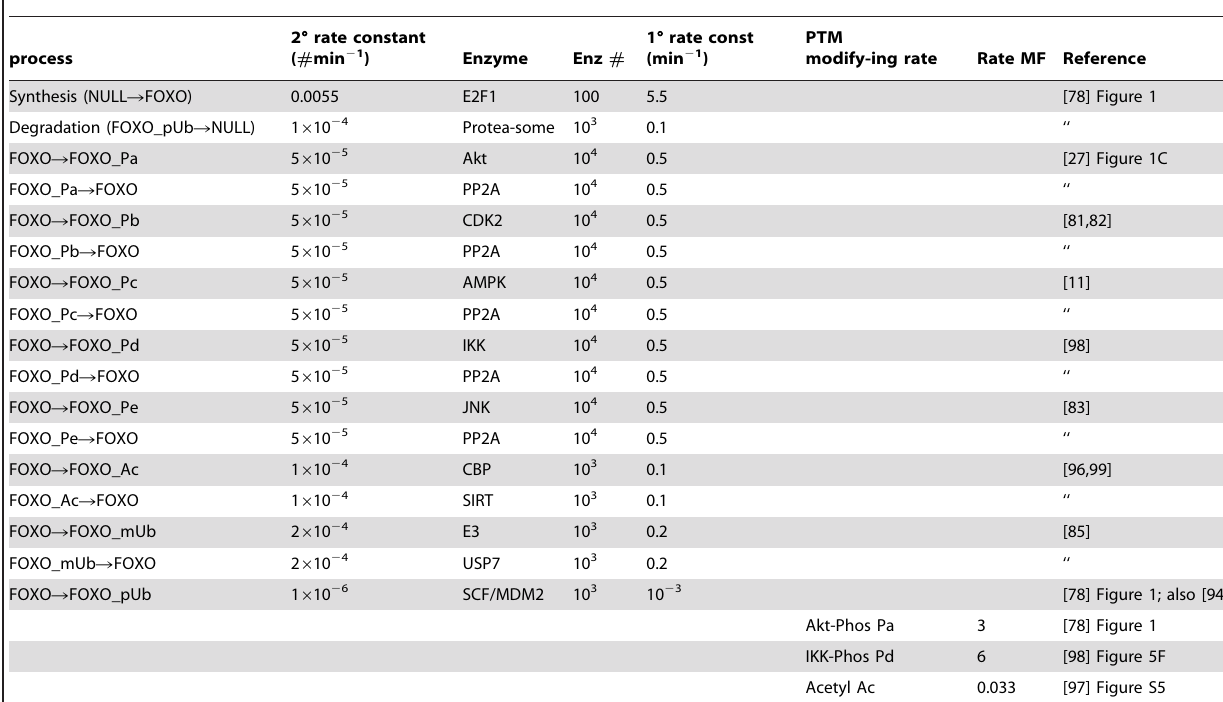
Table 1. Parameters of the model (FOXO synthesis/degradation and PTM addition/removal processes).